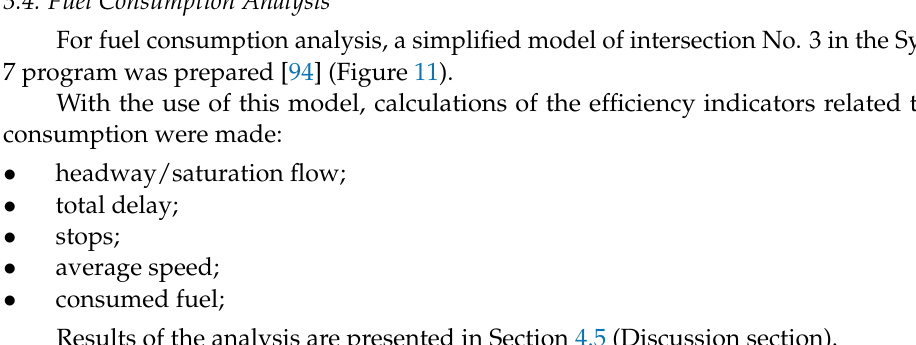
Figure 10. Histogram of entry times after the end of the green signal (data from all intersections).